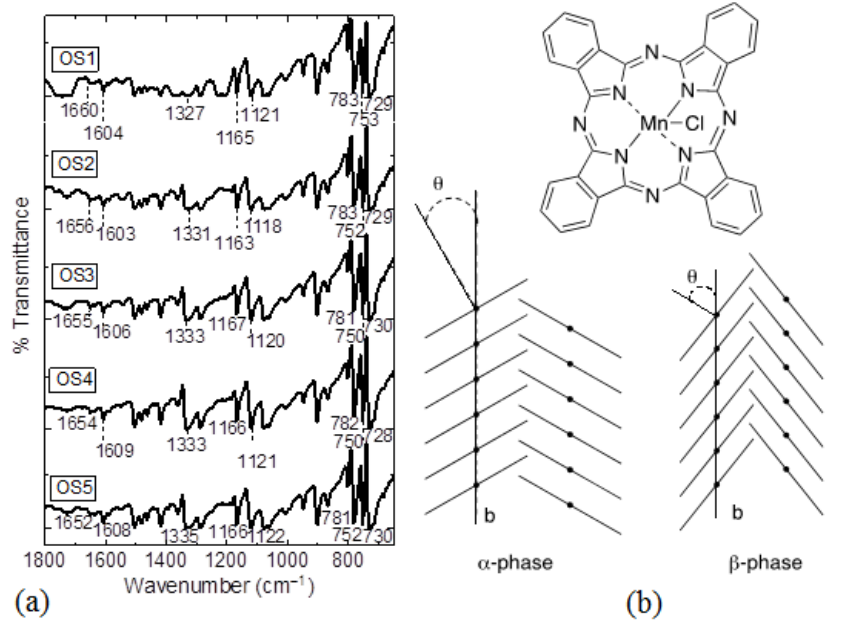
Figure 2. ( a ) IR spectra of doped semiconductors in KBr pellets. ( b ) Structure of α and β -form for MnPcCl. Table 1. Band positions and assignments of MnPcCl – chalcone semiconductors in KBr pellets (pow- der) and films.